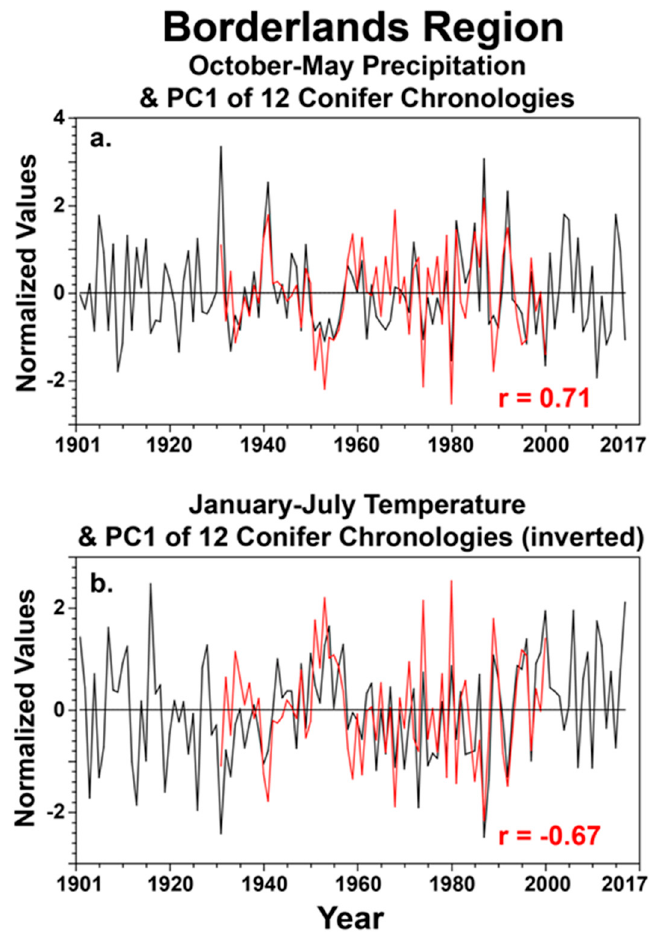
Figure 6. The instrumental precipitation data were totaled monthly for each grid point and then averaged for the study area (28.5–30.5 ◦ N and 102–107 ◦ W) for 1901–2017. These regional precipitation data were then summed for the October–May cool season and correlated with the PC1 scores for the 12 conifer chronologies from the borderlands for the common period 1931–2000 (( a ); PC1 in red). The correlation is r = 0.71 ( p < 0.001). The monthly temperature data were also averaged for the study area and for the months of January–July (plotted for 1901–2017; ( b )). The PC1 time series of tree growth was inverted and is plotted along with the regional temperature series. The correlation is r = − 0.67 ( p < 0.001), prior to inverting the PC1 time series. Regional precipitation for October–May has generally declined since the wet extremes in the 1980s and 1990s ( a ) while January–July temper- atures have increased over the region ( b ). Some of the tree-ring chronologies unfortunately end in